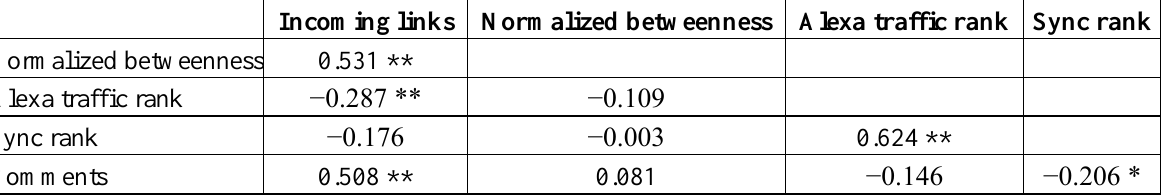
Table 3. Correlation coefficients among blog influence indexes and number of incoming